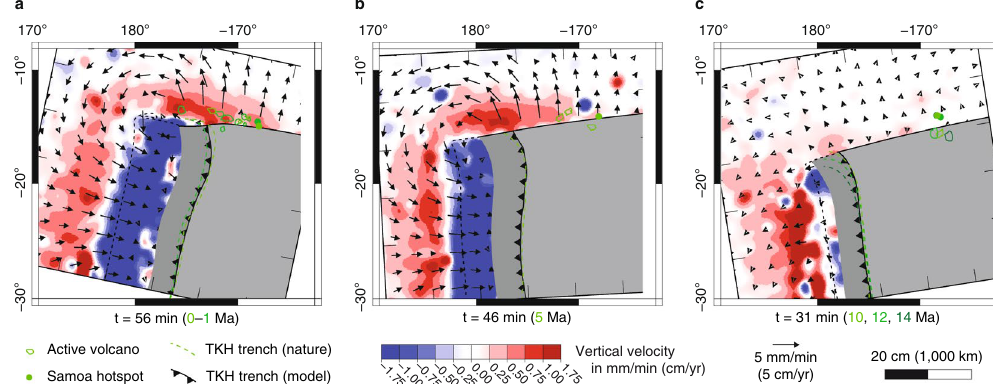
Figure 5. Correlation between Samoan volcanism and predicted SIMU. Overlays of kinematic reconstruction with subduction model mantle flow velocity field computed at 5.5 cm (275 km) depth showing that: ( a ) SIMU superimposes very well with Samoan volcanism at 0 and 1 Ma; ( b ) The correlation possibly starts at 5 Ma; ( c ) Before 10 Ma the SIMU is minimal due to slow slab rollback and the separation between the lateral slab edge and the predicted Samoan hotspot location is large, thus the interaction between SIMU and plume material cannot explain the